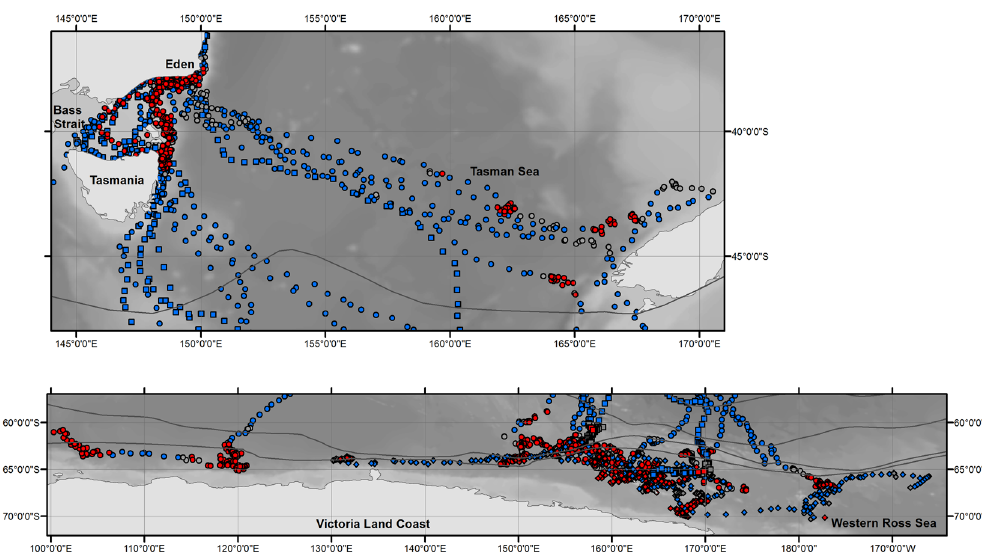
Figure 2. Detail of inset areas shown in Fig. 1. ( a ) The temperate, and ( b ) the Antarctic foraging zones outlined as black boxes in Fig. 1. Location estimates from the state-space model are coloured according to the behavioural state estimate: ‘search’ (red), ‘transit’ (blue) and ‘uncertain’ (grey). Grey lines show climatological oceanic frontal positions 102 . Background shading indicates bathymetry derived from the GEBCO Digital Atlas 103 .